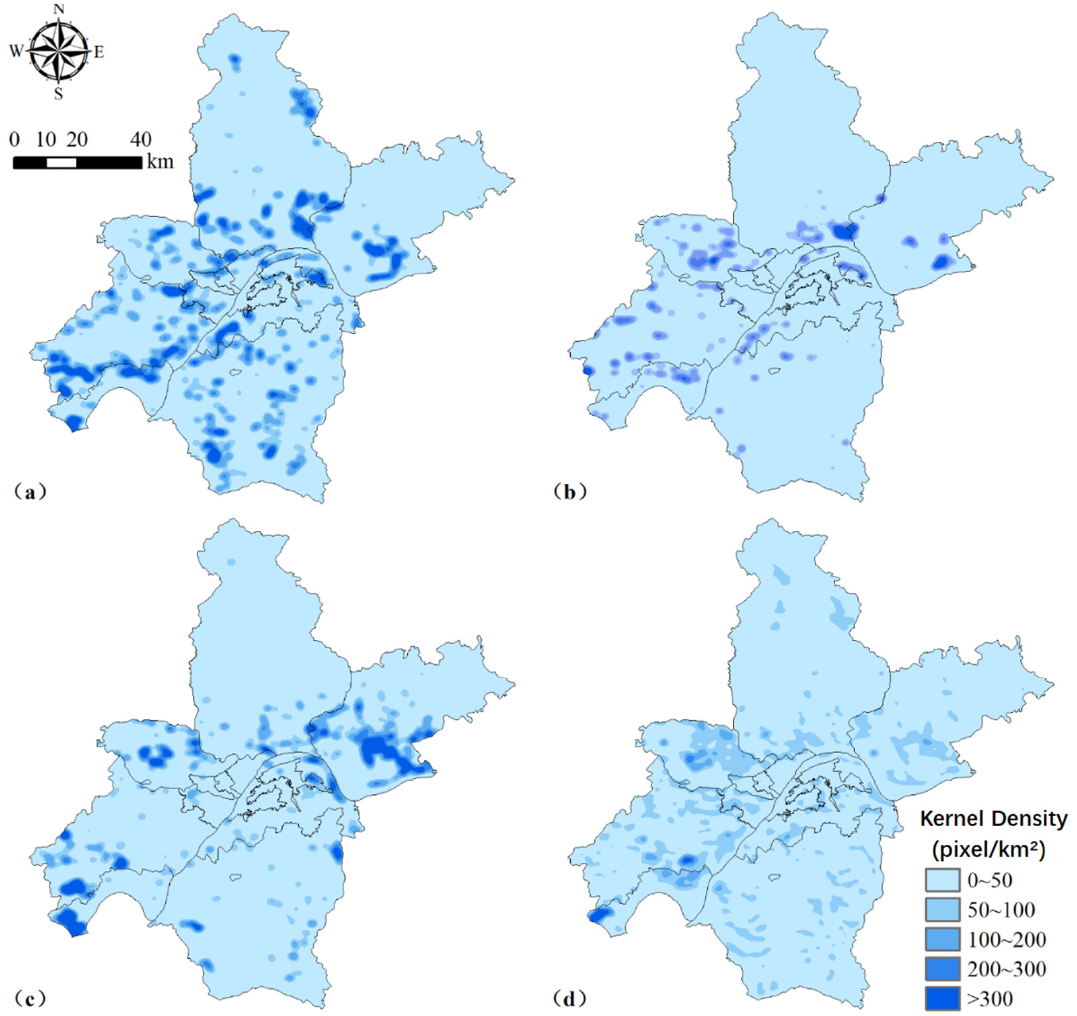
Figure 4. Kernel density of increased water during 1980–1990 ( a ), 1990–2000 ( b ), 2000–2010 ( c ), and 2010–2020 ( d ) in Wuhan city, China. Each pixel represents 30 m × 30 m.